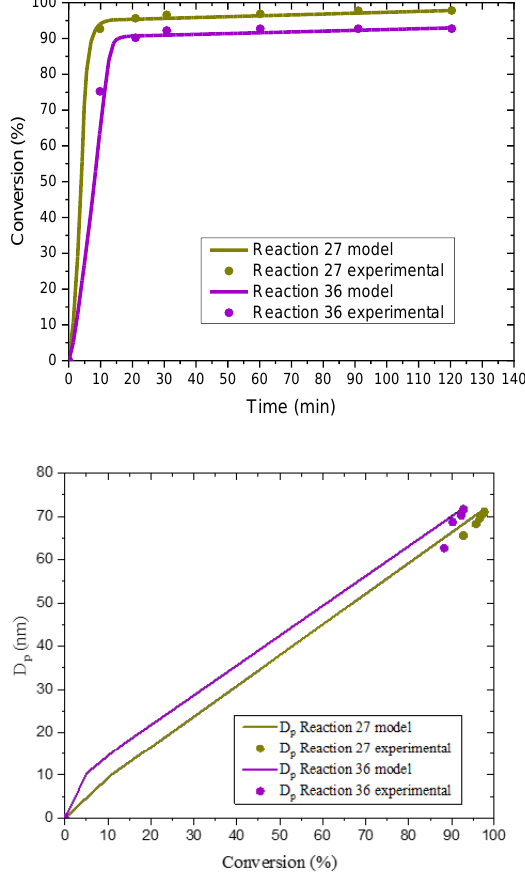
Figure 8. Comparison of simulation (POLYRED) and experimental data for monomer conversion vs. reaction time ( top ) and D p vs. monomer conversion ( bottom ) for experiments E27 and E36.